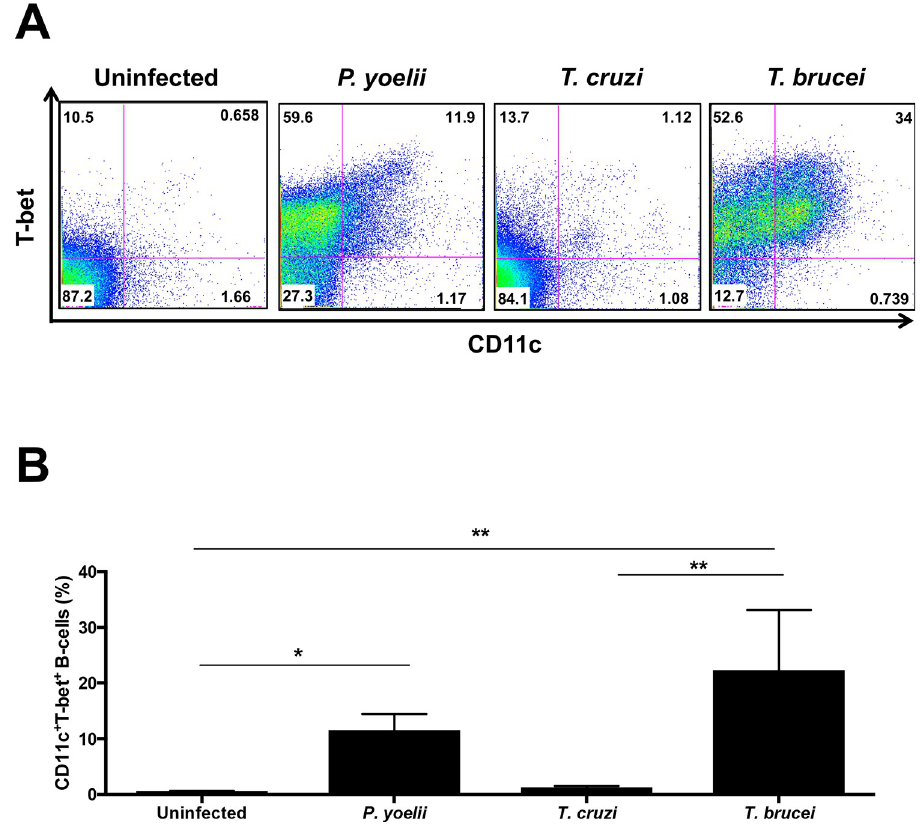
Fig 1. ABCs expand during acute T . b . brucei infection in mice. (a) Representative plots of gated CD19 + splenocytes to identify CD11c + T-bet + B cells from uninfected, day 8 post-infection with either P . yoelii , T . cruzi or T . b . brucei - infected mice. (b) Quantification of CD11c + T-bet + B cells in (a). Bar graph represents the means ± SD of n = 3 mice from at least two independent experiments. Significance assessed by one-way ANOVA with Turkey’s multiple comparison test. � p < 0.05 �� p �